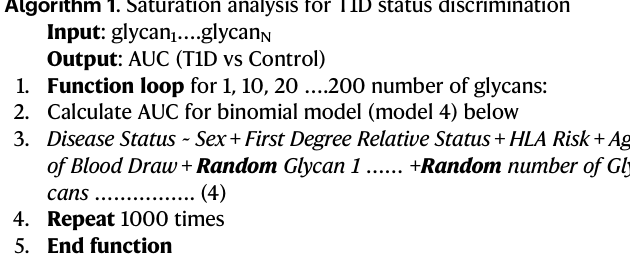
Algorithm 1 . Saturation analysis for T1D status